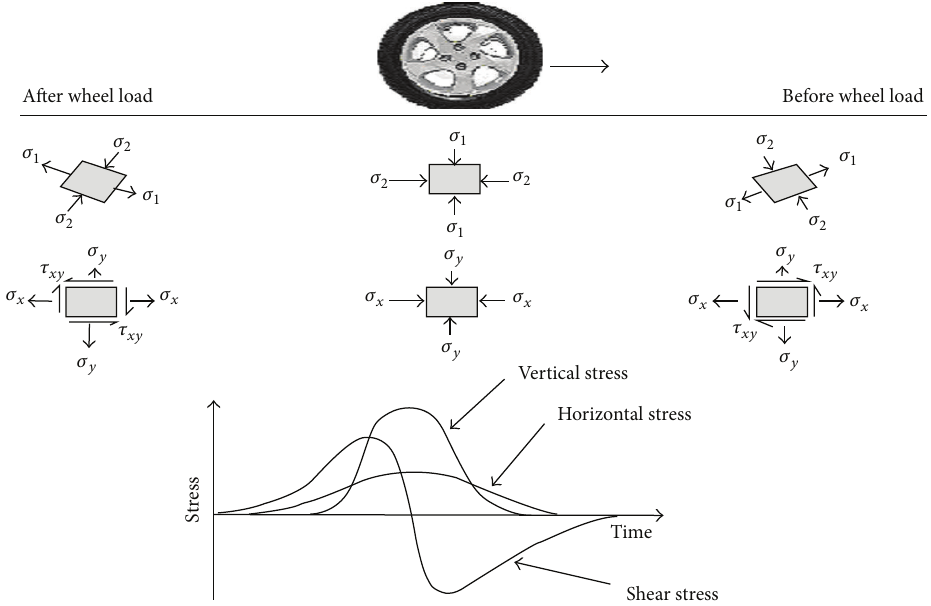
Figure 3: Stress beneath a rolling wheel load